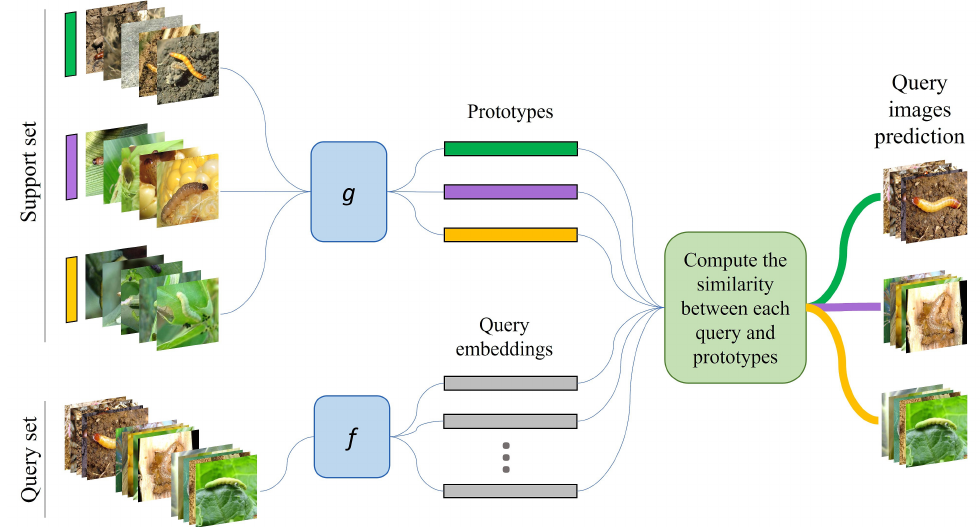
Figure 7. Instance of early stage insect classification in 3-way, 5-shot and q =